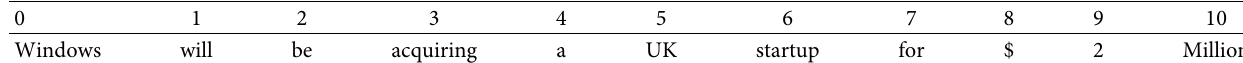
Figure 2: The architecture of the CUSM chatbot. Table 2: Tokenized